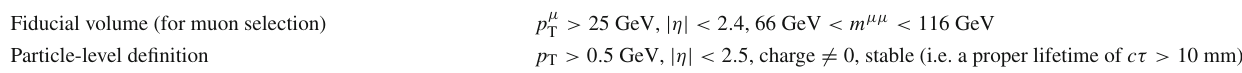
Table 1 A summary of the fiducial volume definition of the measure- ment, the particle-level definition, and the main observables. The first row lists selection criteria for the signal muons (indicated with an μ Fiducial volume (for muon